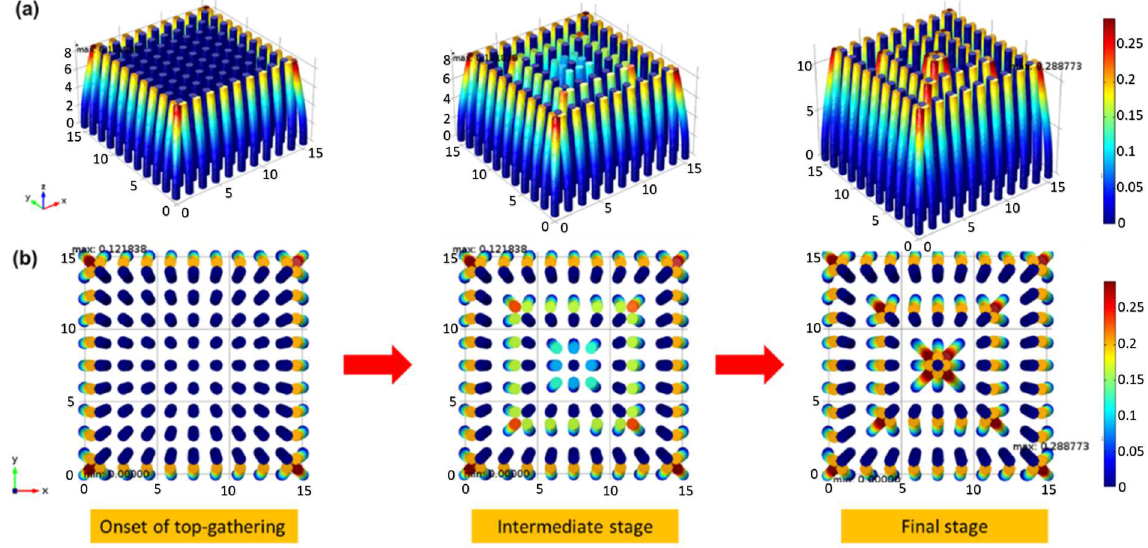
Figure 6. The effect of symmetry on micropillar stability. ( a ) Simulation results showing the progressive top-gathering phenomenon during water evaporation ( b ) Top-view of the micropillars deflection. The micropillars height is ℎ = 9 μm and their diameter is 𝑑 = 0.75 μm. Max number next to the micropillars displays the maximum amount of the deflection in μm. The labeled numbers on the axis are in μm directing the coordinates of the micropillars. The amount of deflection is shown by the bar on the right side of the picture. As it is evident, at the onset of top-gathering, side micropillars initiate the top-gathering process which is due to asymmetric force distribution. As the evaporation progresses the final stage shows the complete top-gathering of the array which is compatible with the experimental data reported in [37].